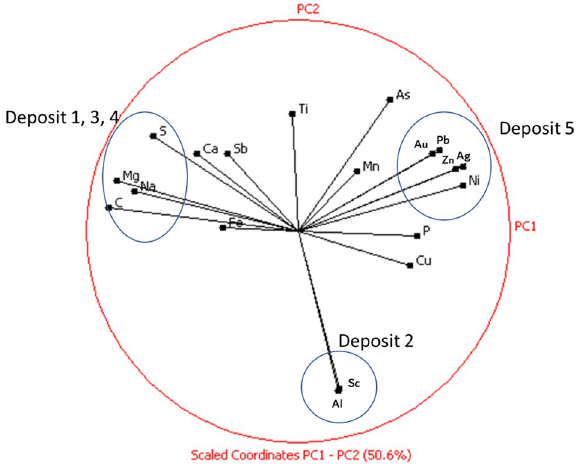
Figure 5. Variables projections on the first factorial plane (PC1/PC2). This plane accounts for about 50% of the total explained variance of the dataset. The blue circles highlight the clusters obtained by the PCA